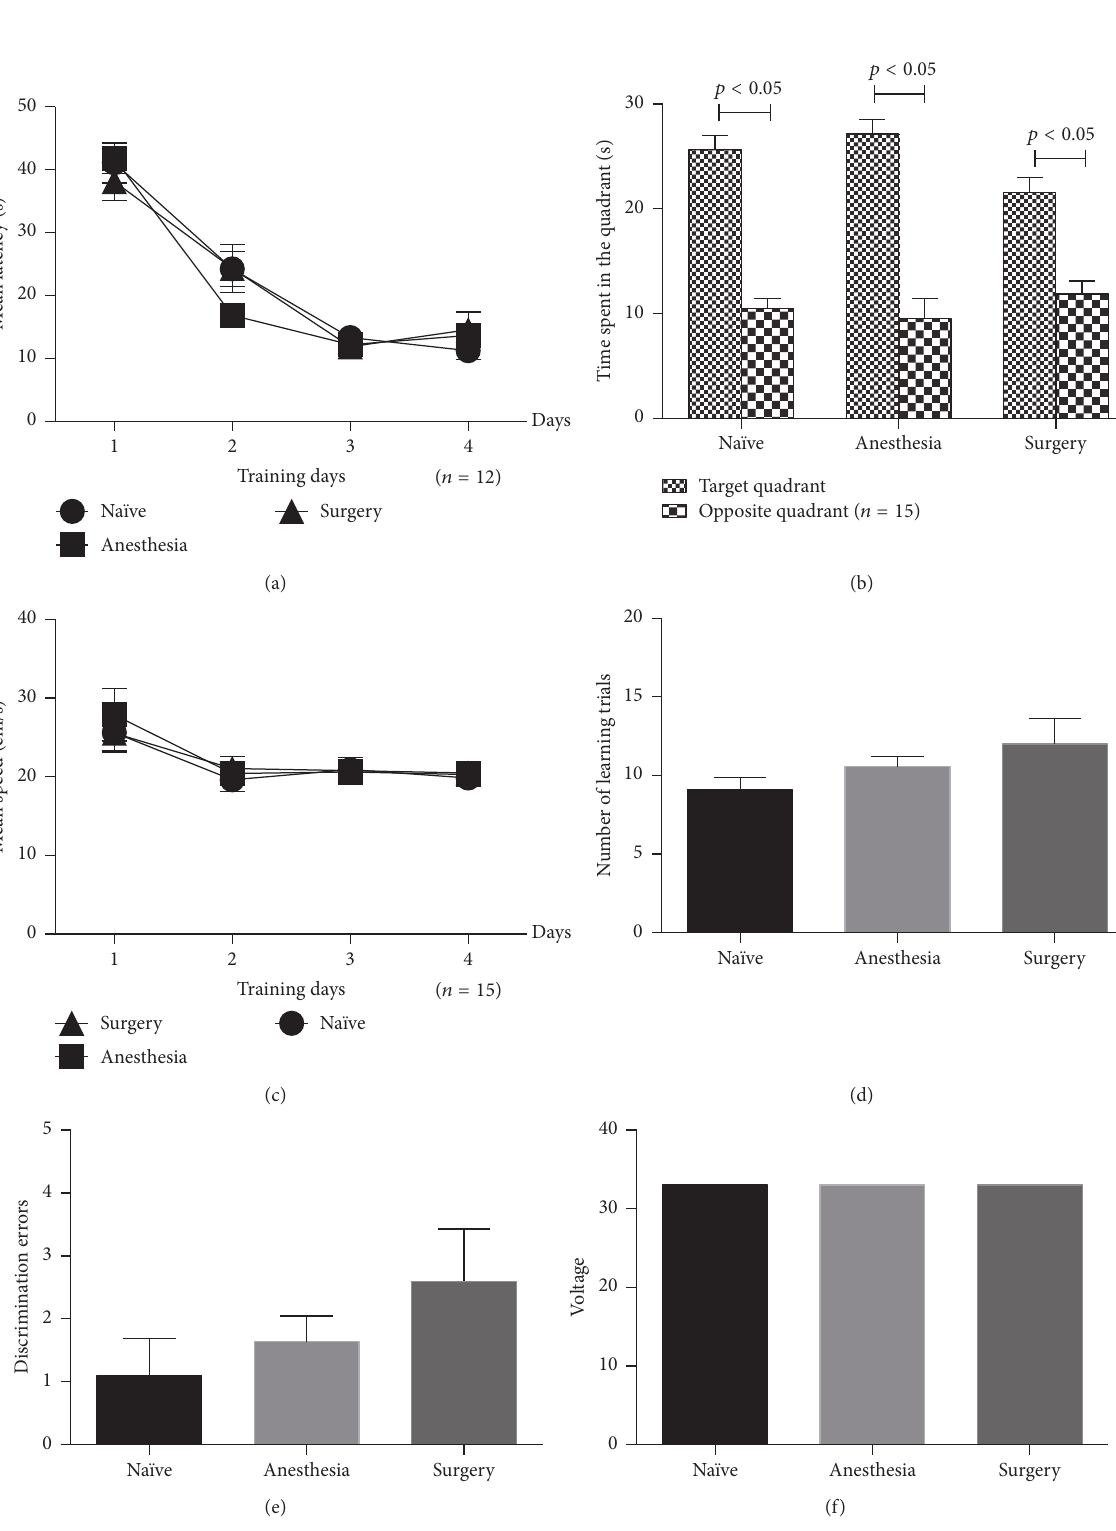
Figure 4: Morris water maze and avoidance learning task test results of short term. No significant differences were observed among the three groups. (a) Mean latency; (b) swimming time in the target quadrant; (c) average swimming speed; (d) the number of learning trials; (e) discrimination errors; (f) shock voltage ( 𝑛 = 15